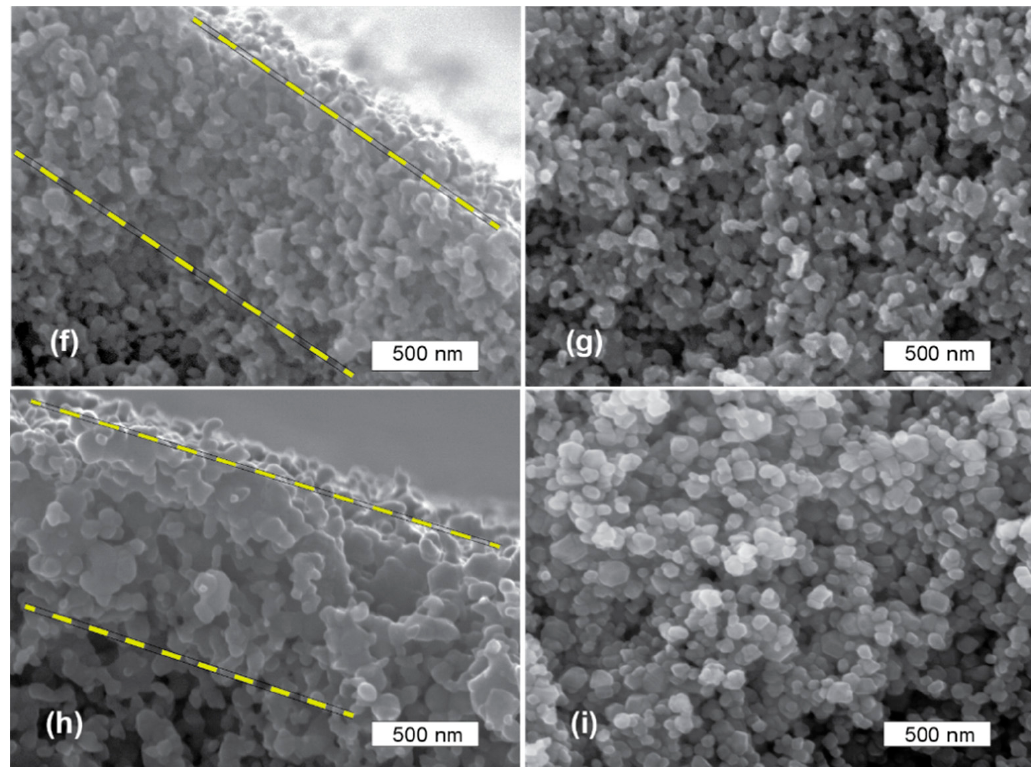
Figure 5. SEM images of fractures of silver NP lines sintered in optimal modes: ( a ) The general view of the fracture of the line on a substrate sintered by radiation with a wavelength 980 nm; ( b , d , f , h ) External fracture areas including the surface borders of the sample; ( c , e , g , i ) Internal fracture areas. Sintering was done by pulsed laser sources with wavelengths ( b , c ) 527 nm, ( d , e ) 1054 nm and CW laser sources with wavelengths ( f , g ) 527 nm, ( h , i ) 980 nm.